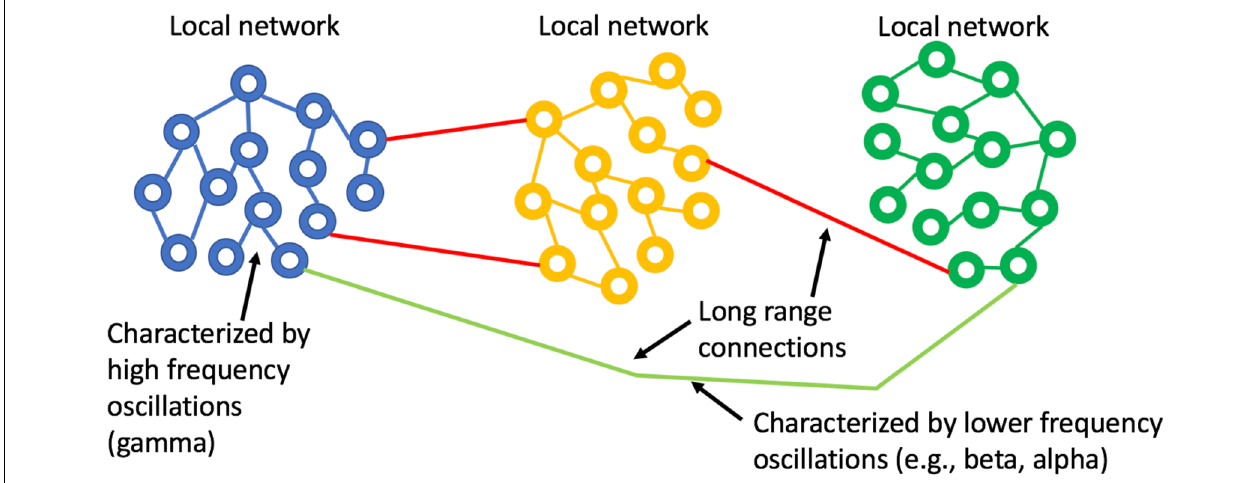
FIGURE 1 | Small world network topology. The highest density of synaptic connections is local and longer-range connections are sparse. This topology is consistent with high frequency, short-range oscillations (gamma) being local and longer range, slower oscillations being regional or global.